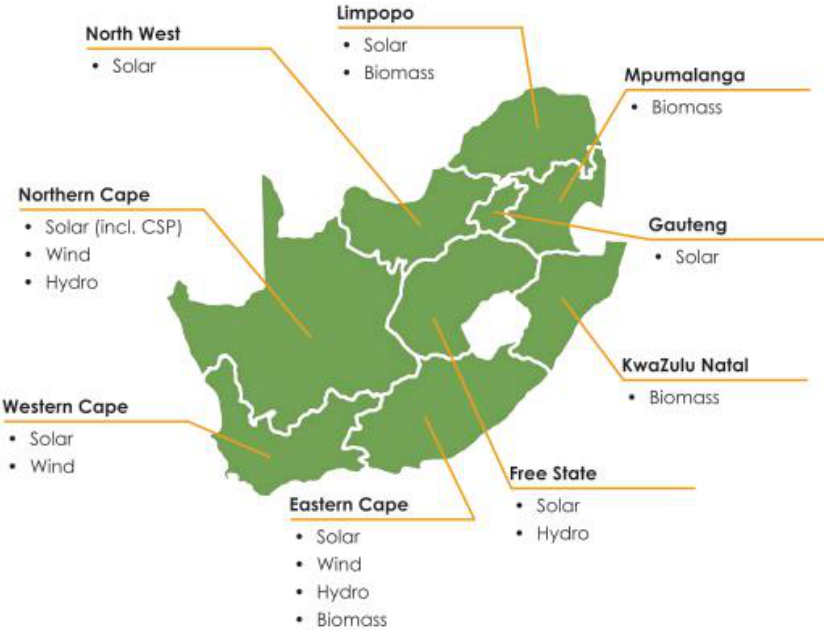
Figure 3. Renewable energy distributio n at provincial scale in South Africa